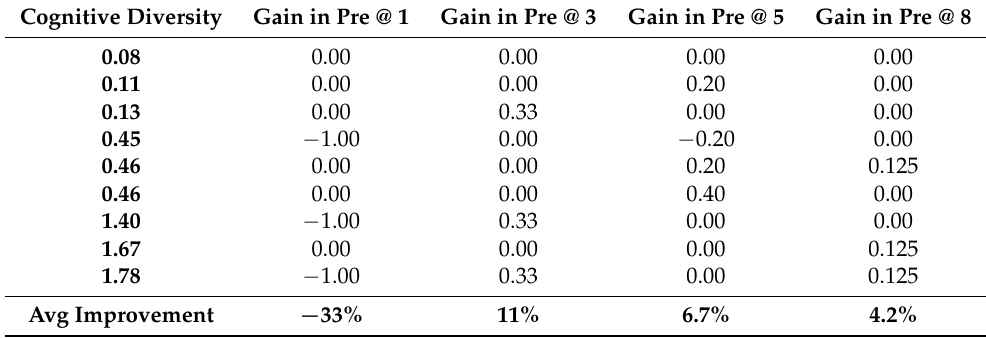
Table 10. Difference between precision results of combined and individual models using RC ( A , B ) for the highest three cognitive diversity tests, and SC ( A , B ) for the lowest six cognitive diversity tests.